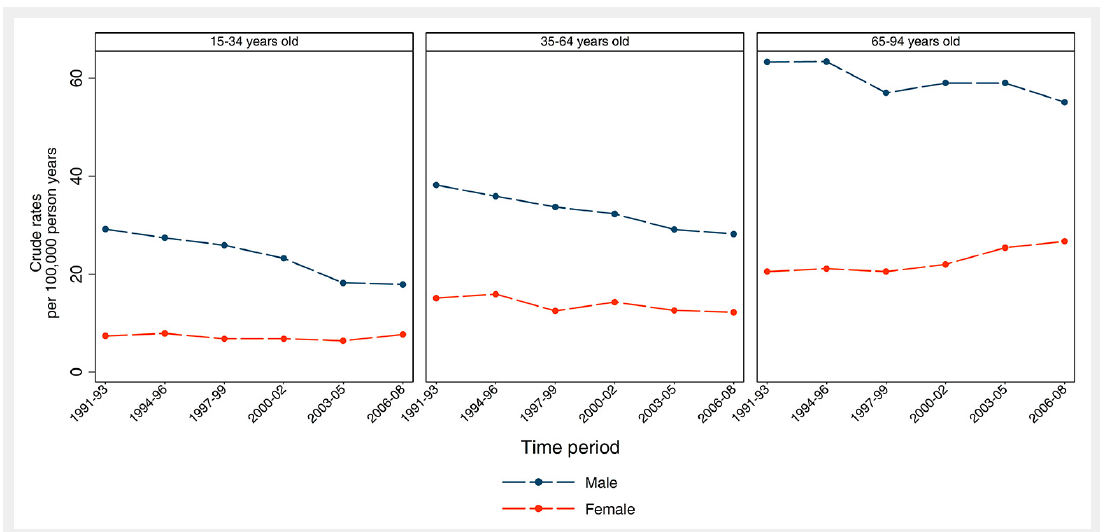
Time-trends of suicide rates in Switzerland by age group and sex, 1991–2008. In men there was a decline in all age groups (all p <0.001); in women there was no change over time in the youngest age group (p = 0.40); a slight decline in the age group 35–64 years and an increase in the oldest age group (both p